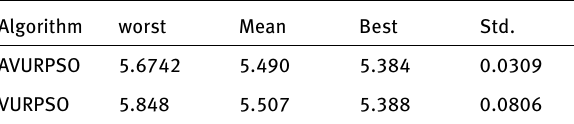
Table 5: A comparison between AVURPSO and VURPSO on statistical analysis of fitness function in Example 2.